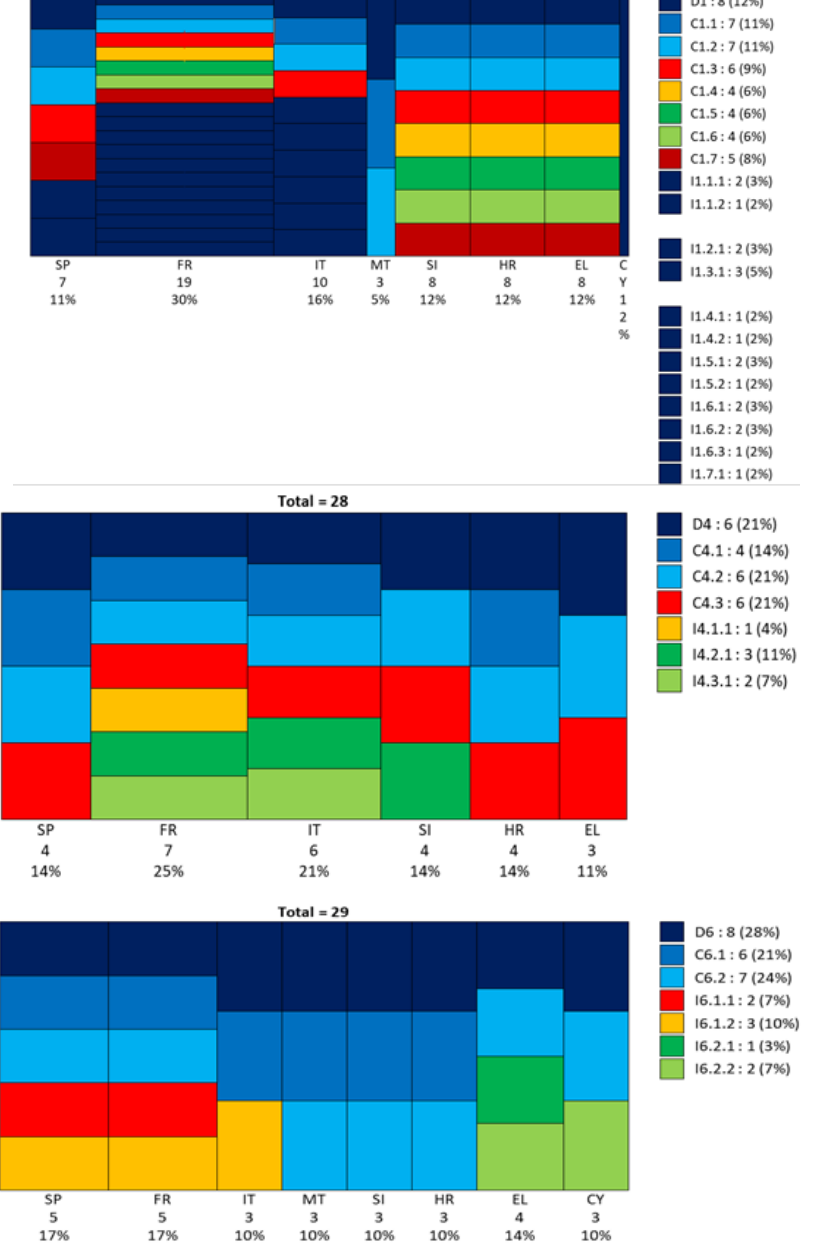
Figure 5. Application of Com Dec 2010/477/EU criteria (C) and indicators (I) in Art 9 for biodiversity descriptors by Mediterranean MSs in 2012.